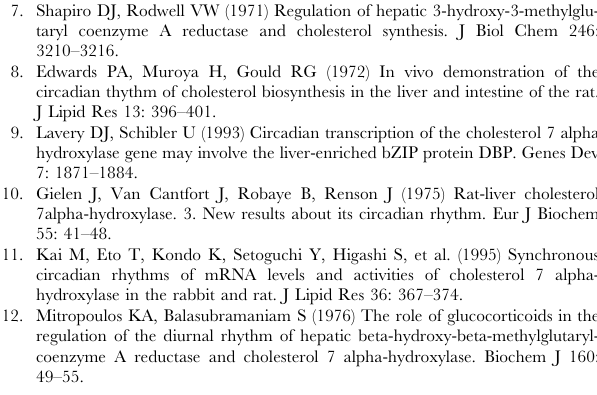
Found at: doi:10.1371/journal.pone.0006843.s002 (0.83 MB TIF) Figure S3 Found at: doi:10.1371/journal.pone.0006843.s003 (0.67 MB